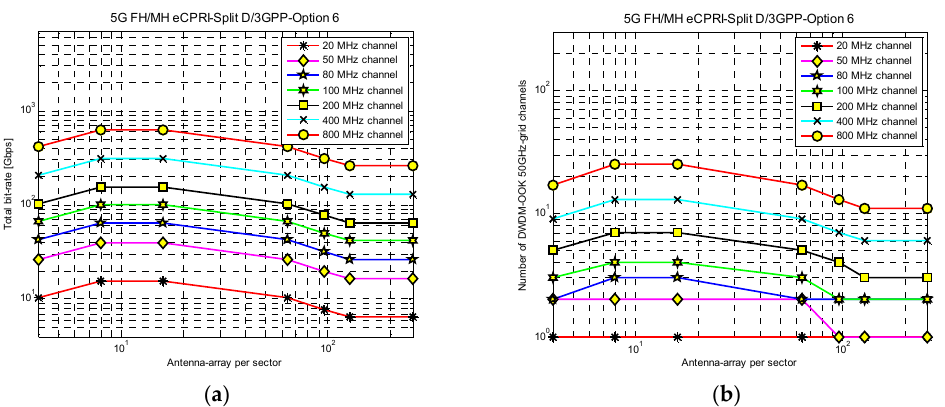
Figure 10. Calculation results of optical resources needed to connect 4-sector gNB-DU/RRH to optical FH/MH as a function of antenna elements number of massive-MIMO array (calculation parameters changing according to Tables 1 and 2): ( a ) total bit-rate for radio BB channels digitized to eCPRI format—3GPP—Option 6 / CPRI Forum—Split D (Figure 7a,c); ( b ) number of DWDM-OOK 50GHz-grid channels for radio BB channels digitized to eCPRI format—3GPP—Option 6 / CPRI Forum—Split D (Figure 7a,c).